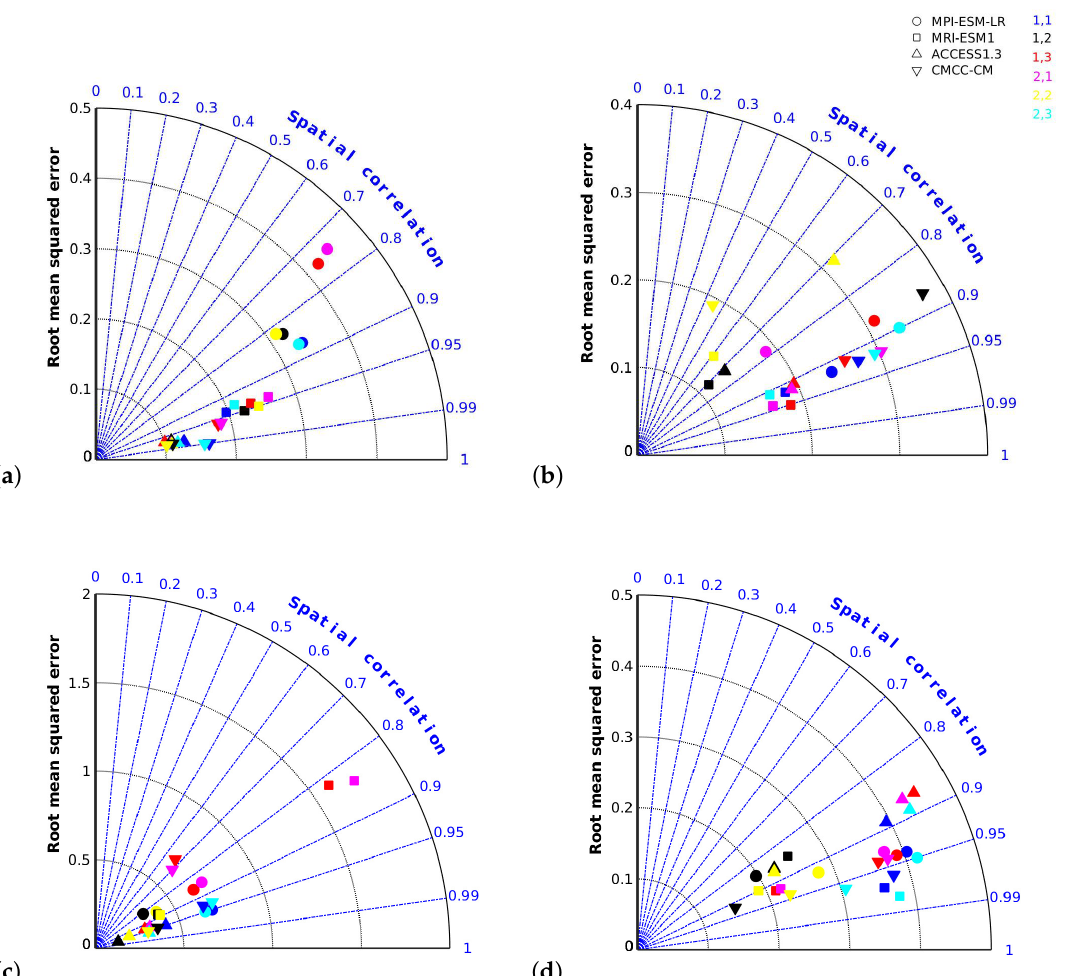
Figure 6. Taylor diagrams for root mean squared error versus spatial correlation for all the weather patterns (WPs) and fifth-phase Coupled Model Inter-Comparison Project (CMIP5) models: ( a ) mslp, ( b ) q700, ( c ) u700, and ( d ) v700. The distance from the origin to a certain point indicates the root mean squared error and the angle from the vertical axis represents the spatial correlation between WPs from models and